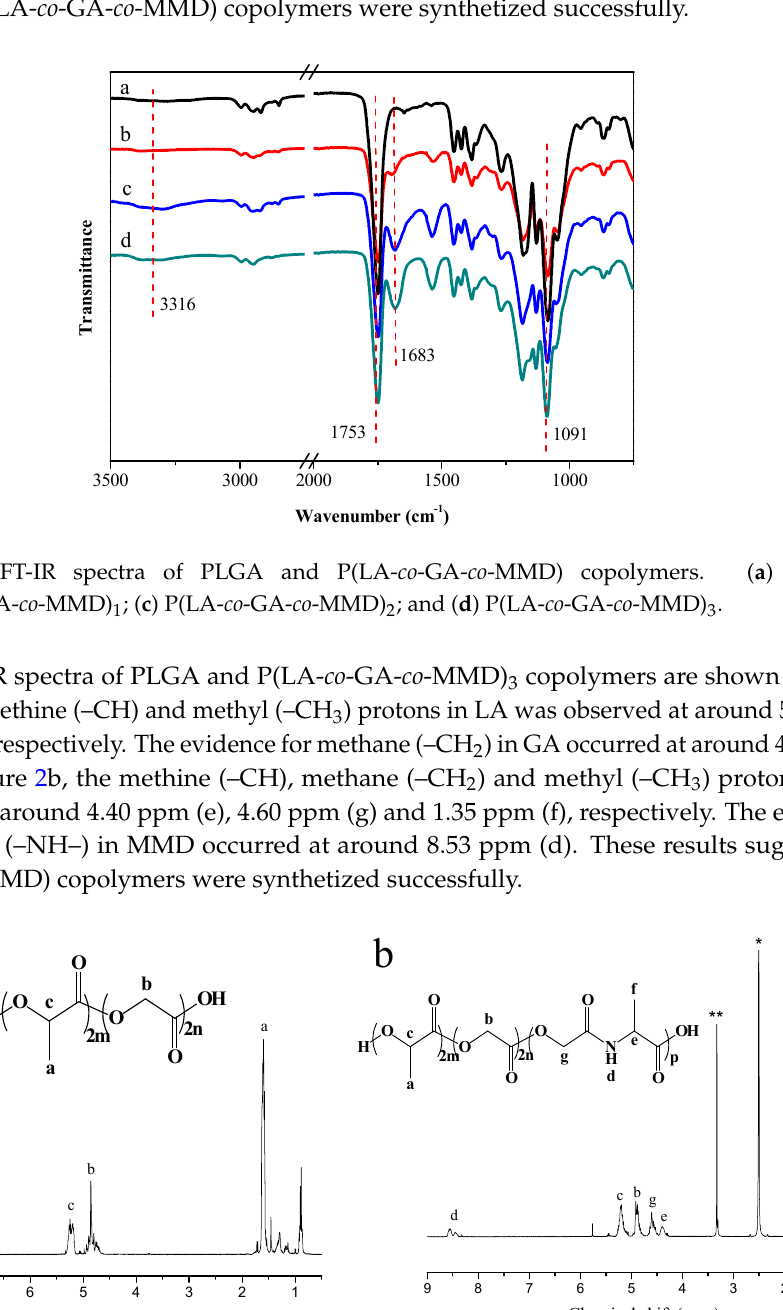
Figure 2. 1 H NMR spectra of PLGA and P(LA- co -GA- co -MMD) 3 copolymers. ( a ) 1 H NMR spectra of PLGA copolymer in CDCl 3 ; ( b ) 1 H NMR spectra of P(LA- co -GA- co -MMD) copolymer in DMSO-d 6 , * Solvent peak; ** H 2 O peaks.